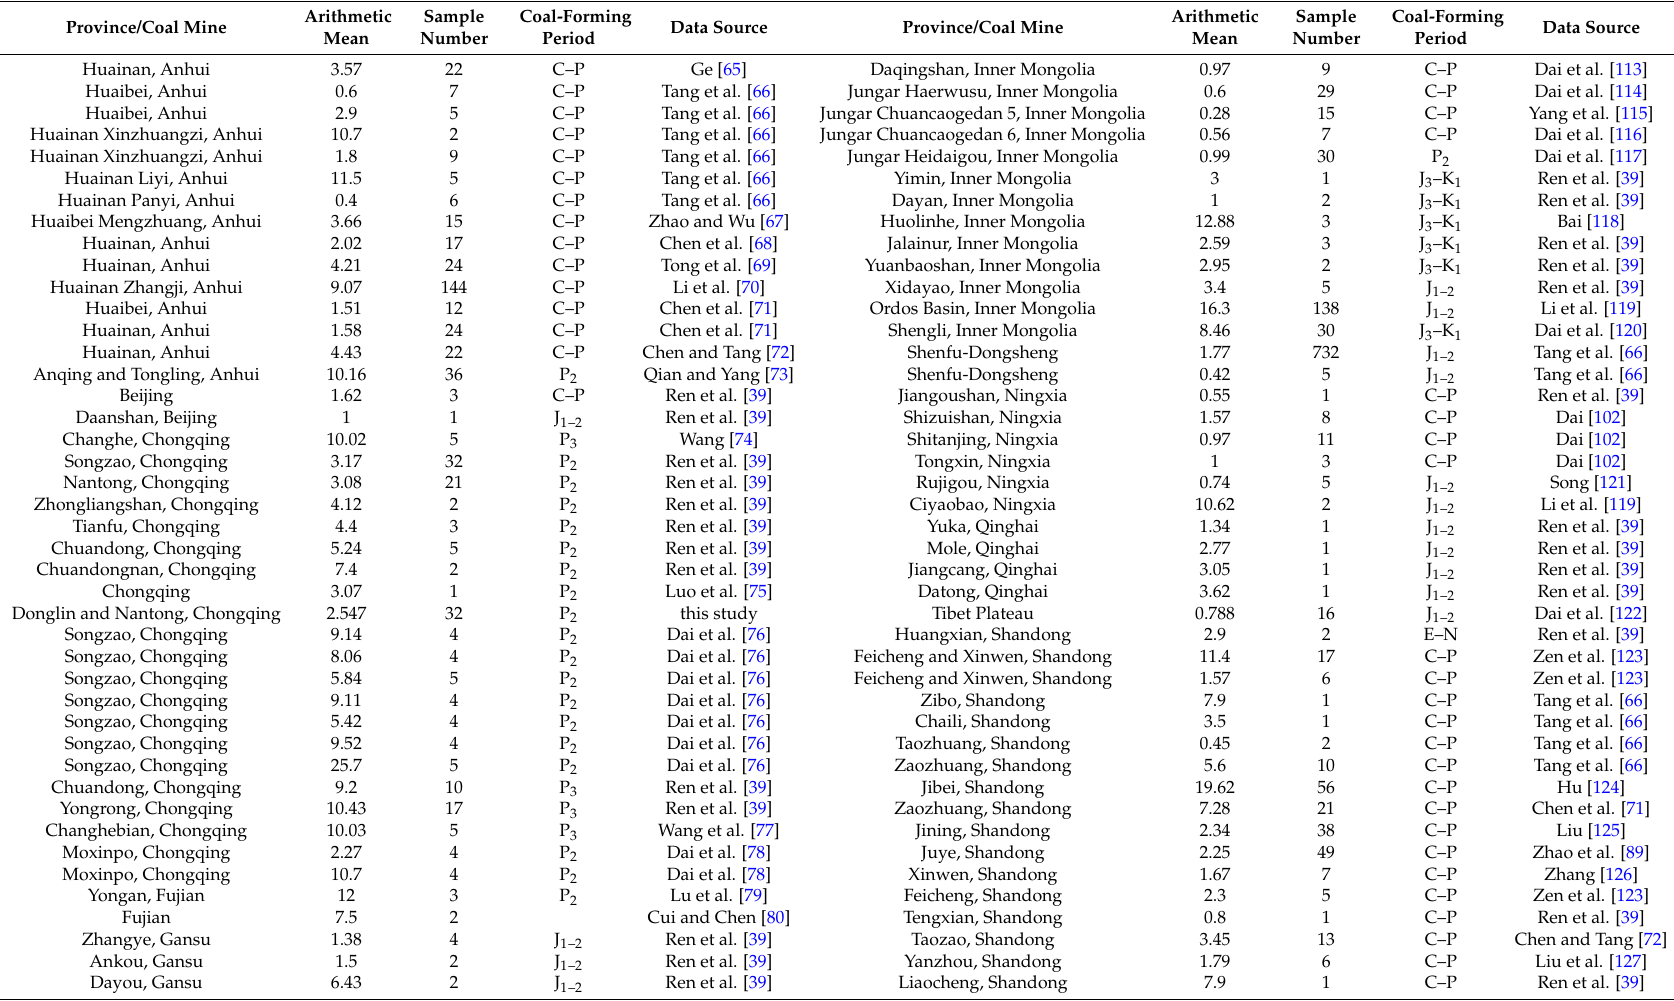
Table 1. Arsenic concentration in Chinese coals (mg/kg). Data are quoted from references of